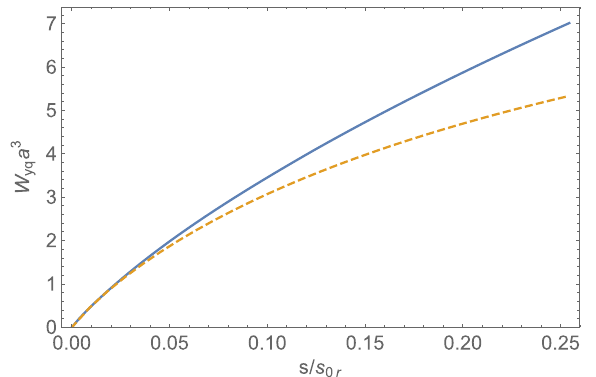
FIG. 11. Quad wake at offset y ¼ 0 . 5 mm for the RadiaBeam/ LCLS dechirper, comparing the numerical inverse Fourier trans- form of the impedance equation, Eq. (35) (blue curve), with the approximation, Eq. (36) (the dashes).